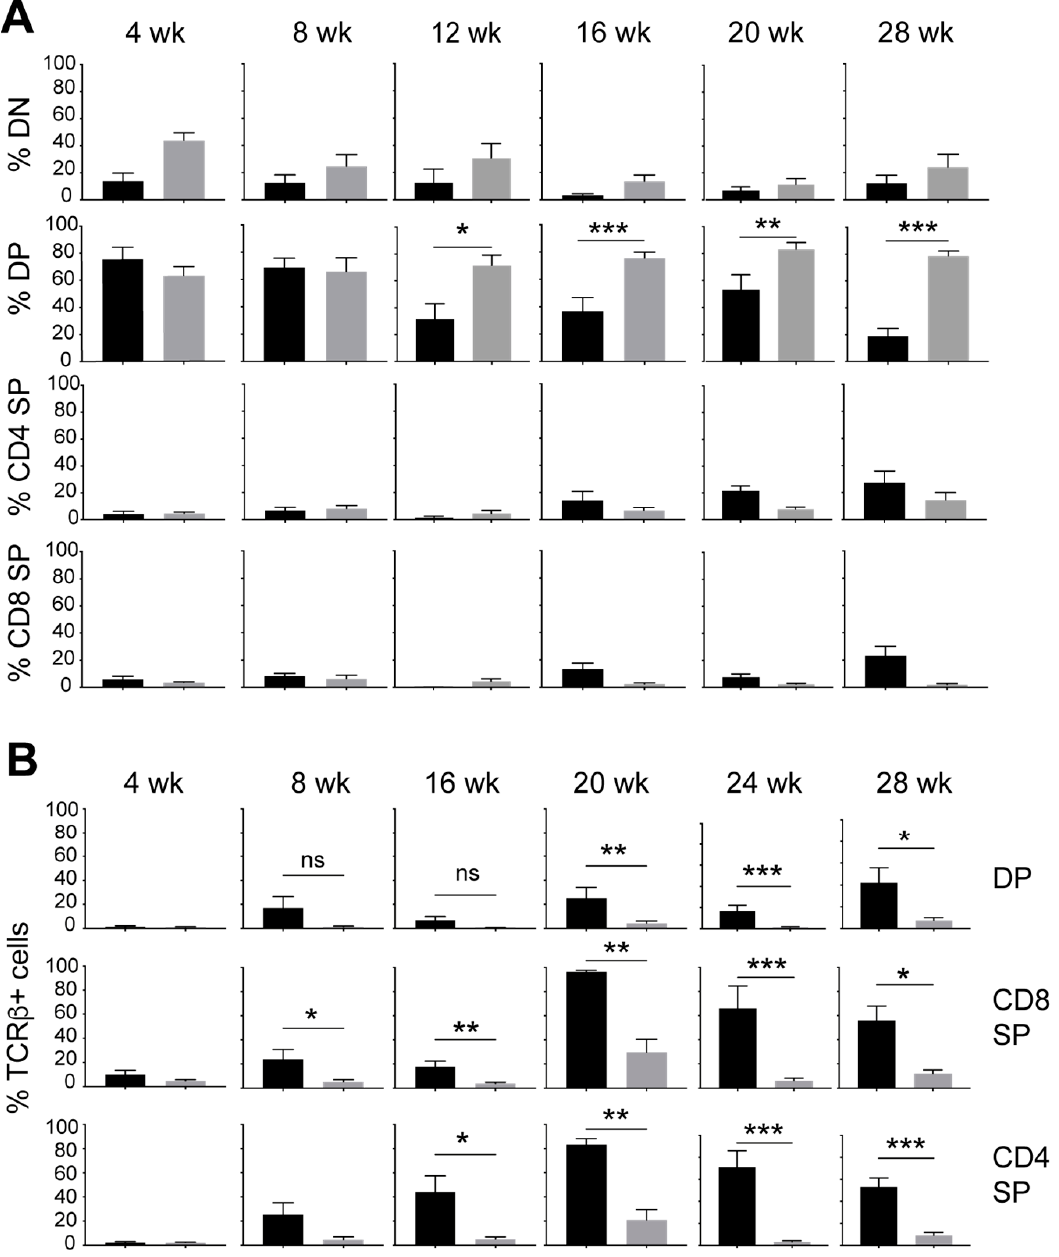
Figure 2. IL-15 deficiency in NOD. Scid mice causes an increase in the proportion of DP thymocytes while decreasing TCR-positive cells. ( A ) Frequency of DN (CD4 − CD8 − ), DP (CD4 + CD8 + ) and SP (CD4 + CD8 - , CD4 − CD8 + ) subsets at different age groups of NOD. Scid (black bars) and NOD. Scid.Il15 − / − (gray bars) mice. ( B ) Proportion of cells expressing TCR in DP, CD4 + SP and CD8 + SP subsets. n = 4– 8 mice per group. Mean and standard deviation (SD) are shown. Statistical significance was calcu- lated using Mann–Whitney’s test. * p > 0.05; ** p > 0.01; *** p > 0.001.